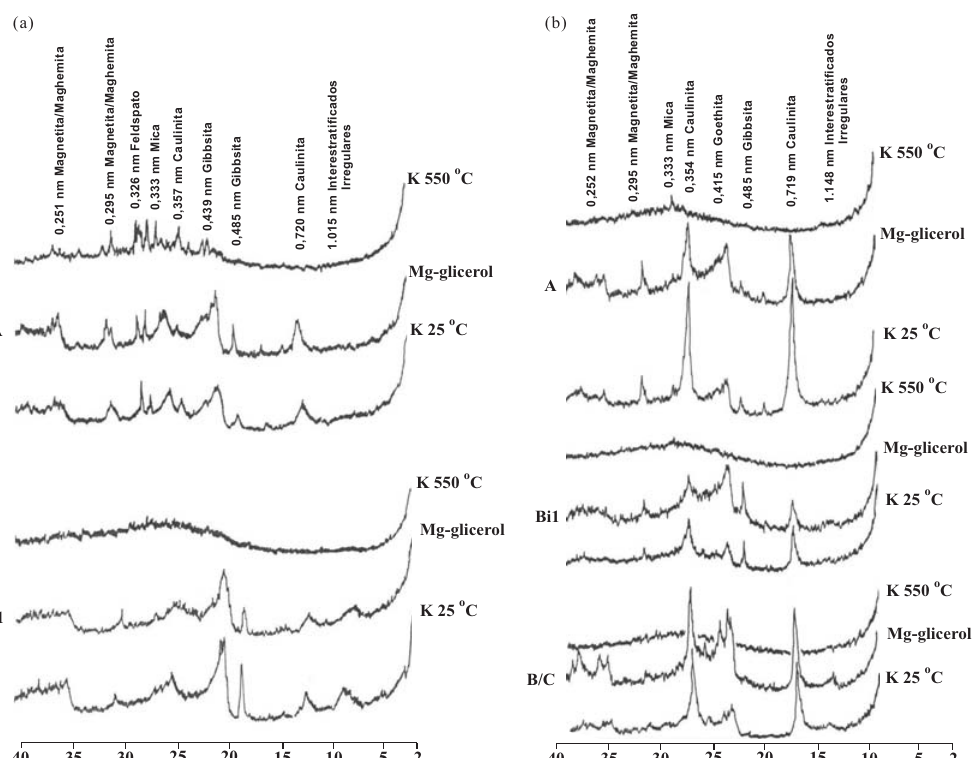
Figura 1. Difratogramas de raios X do perfil 1 – Cambissolo Háplico Tb distrófico típico. (a) fração silte; (b) fração